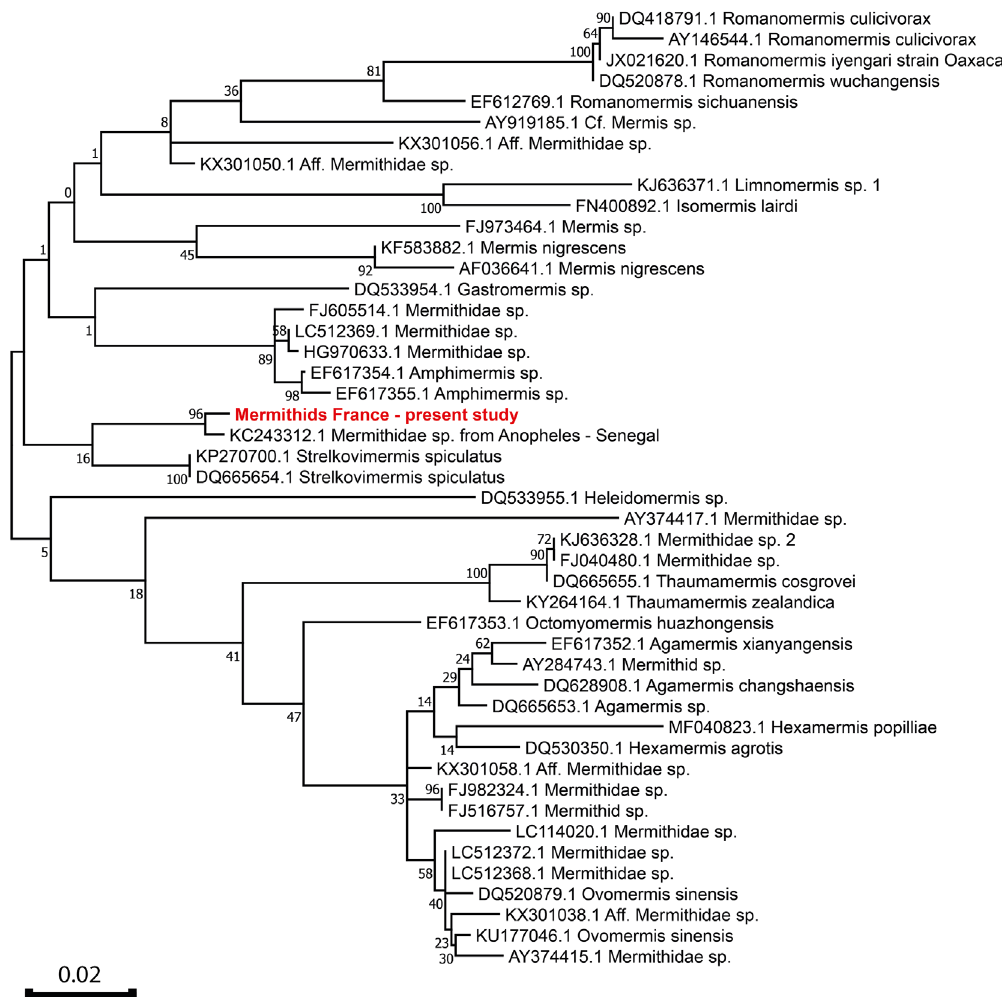
Figure 2. Maximum-likelihood tree based on partial 18S rDNA sequences available in GenBank, including the sequence of mermithids processed in the present study (in red). Bootstrap values are indicated on speci fi c